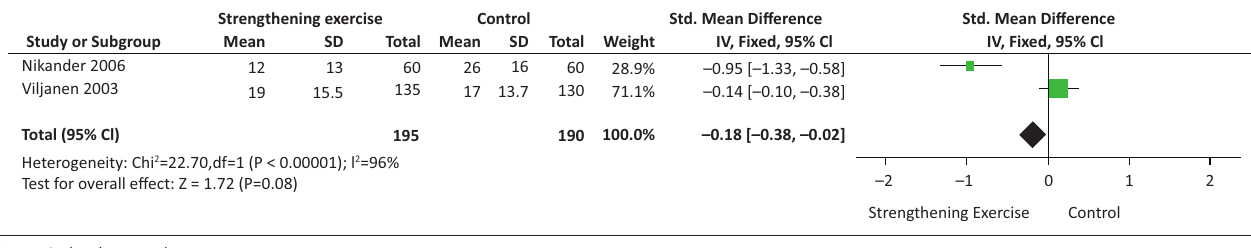
FIGURE 3: Forest plot of the effect of strengthening exercise versus no therapeutic exercise (control) in improving quality of life measured at 12 months.